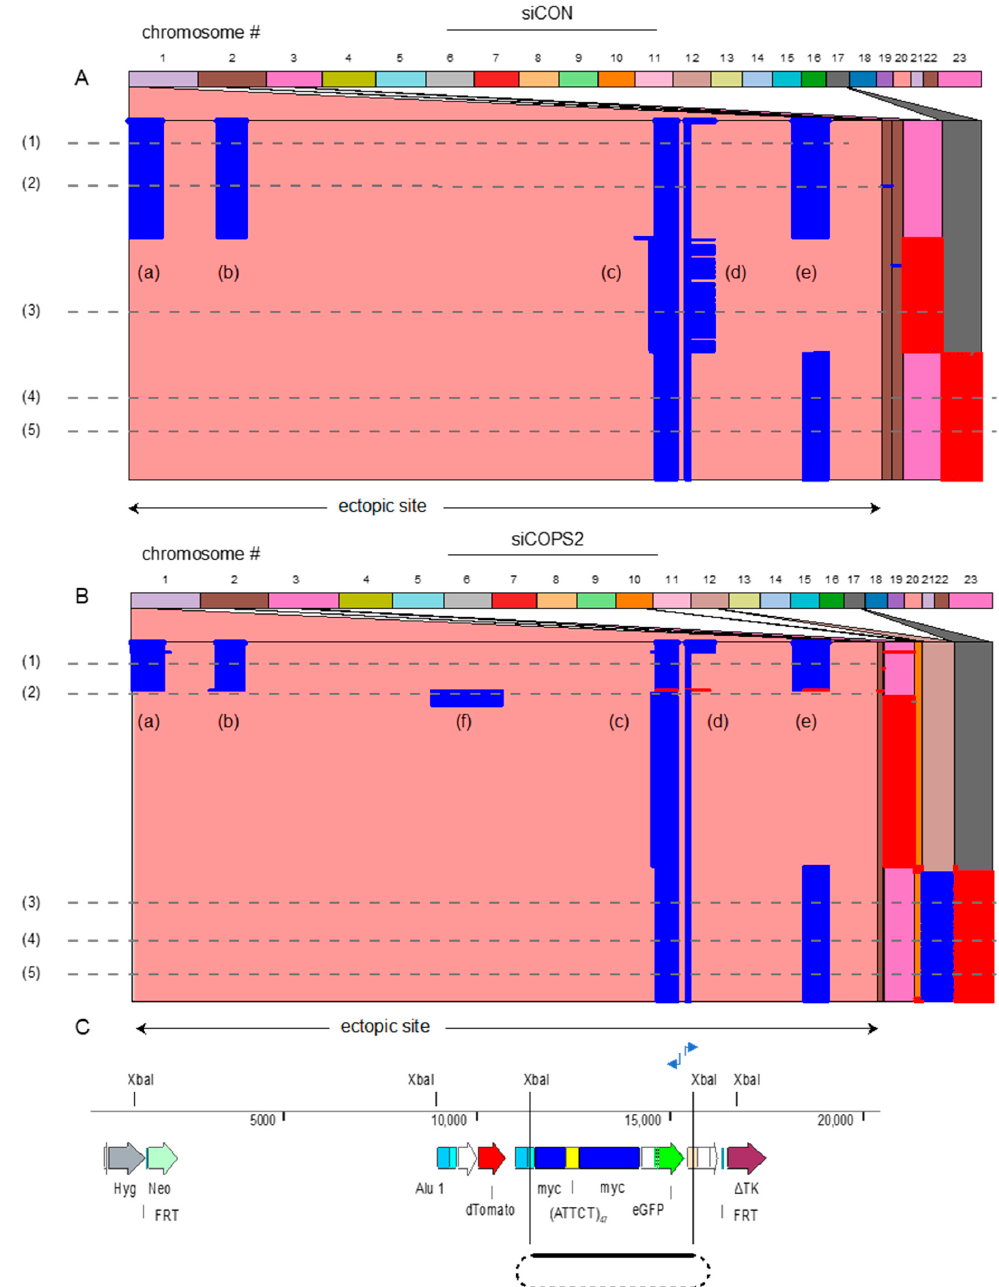
Figure 11. COPS2 knockdown increases genomic instability at the (ATTCT) 47 ectopic site. Panel ( A ) contains 14,070 unique deduplicated reads derived from cells treated with siCON; panel ( B ) contains 13,501 unique deduplicated reads derived from cells treated with siCOPS2. Letters (a)–(f) refer to template switching domains. ( C ) schematic of the ectopic site aligned with the Ribbon [89] maps of ( A,B ). Domain (d) comprises sequences initiated at the forward iPCR primer; domain ( C ) contains the reverse complement of sequences initiated at the reverse iPCR primer. Dashed lines (1)–(5) are reads that are detailed in Supplementary Figures S1–S3. The positions of the forward and reverse iPCR primers are shown. Read segments in red are in the reverse orientation to the standard short-long arm chromosome orientation. The ectopic site is shown below the alignment; nonallelic chromosome templates are shown above the alignment. ( C ) Schematic of the ectopic site aligned with the Ribbon maps of ( A , B ); including the predicted ectopic site XbaI-XbaI circle template for